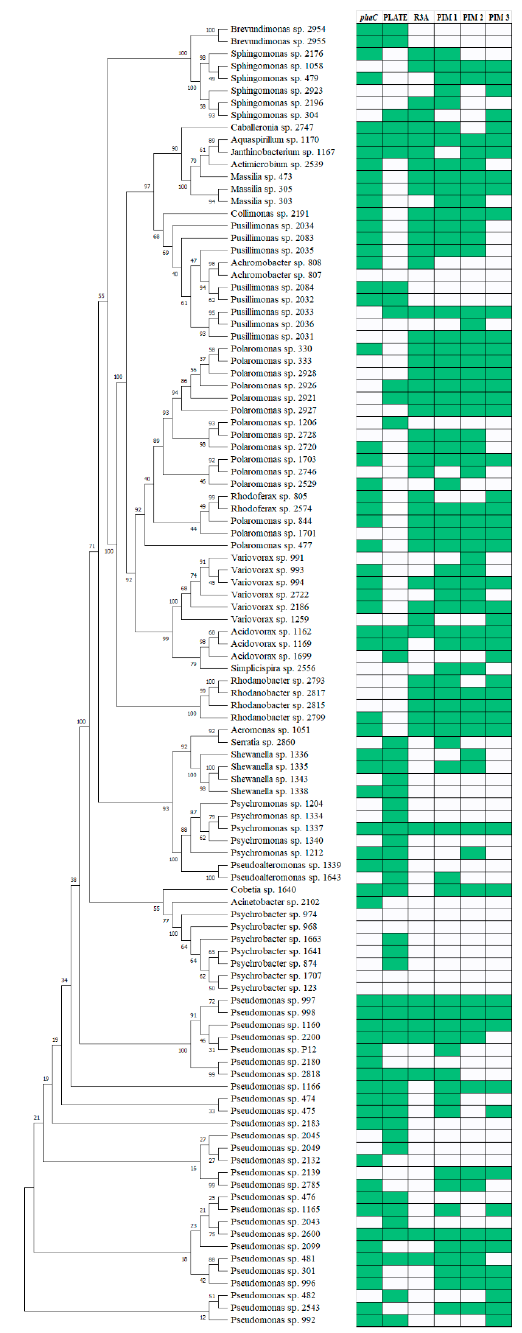
Figure 2. Phylogenetic tree based on partial 16S rRNA gene sequences belonging to the Proteobacteria phylum lined up with the results from the PHA screening with various methods. The tree was built using the neighbor-joining method. Bootstrap values are indicated at the nodes. Green boxes indicate a positive score. phaC –presence of the 550 bp DNA fragment of the phaC gene; PLATE—presence of characteristic fluorescence on R3A agar plates with Nile Red after UV exposure; R3A—presence of red-fluorescing granules in Nile Red stained cells cultured on R3A broth; PIM1—presence of red-fluorescing granules in Nile Red stained cells incubated in PIM1 medium; PIM2—presence of red-fluorescing granules in Nile Red stained cells incubated in PIM2 medium; PIM3—presence of red-fluorescing granules in Nile Red stained cells incubated in PIM3